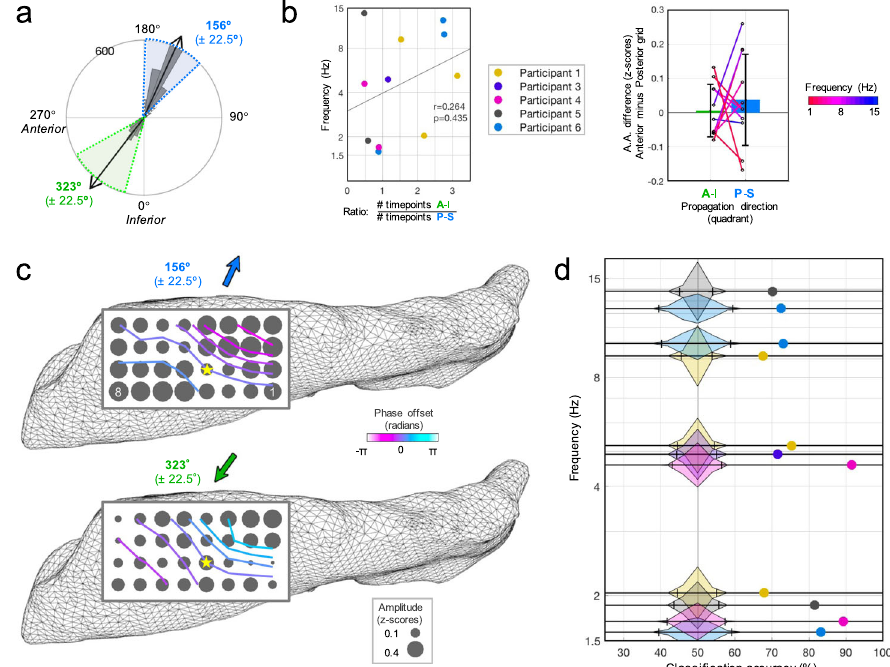
Fig. 5 Topographic pattern of oscillation strength predicts propagation direction. a Example of angle split procedure for the distribution of bimodal TW timepoints (Participant 5, 13.8 Hz oscillation). Timepoints having wave directions within a 45° spread of either mode were grouped into separate conditions. b Across participants, the frequency ( n = 11) of a predominant (peak) oscillation did not predict whether it tended to propagate toward the temporal or septal pole more often, assessed by the ratio of total timepoints in each direction condition (left panel; p = 0.44, Spearman correlation, A-I: antero-inferior direction, P-S: postero-superior direction). Analytic amplitude (A.A.) differences between the anterior and posterior halves of the grid for these same frequencies (colored lines; compiled across participants) were not different between the two directions (right panel; p = 0.57, two-sided paired t -test; mean ± standard deviation). c Average channel amplitudes (dot size: mean z -score) across all timepoints split by condition, for example, frequency in ( a ), suggestive of distinct surface activity topography for each propagation direction. Contour lines overlaid are interpolated estimates of phase gradient offsets (circular mean across all condition timepoints) along the surface relative to electrode #12 (yellow star). d Probability density envelopes (10,000 iteration shuf fl ed distributions, 4% bins) for SVM model classi fi cation accuracy among all peak frequencies across participants (chance: 50%, hatch marks: 99% CI) and actual/observed values (colored dots; see legend in ( b